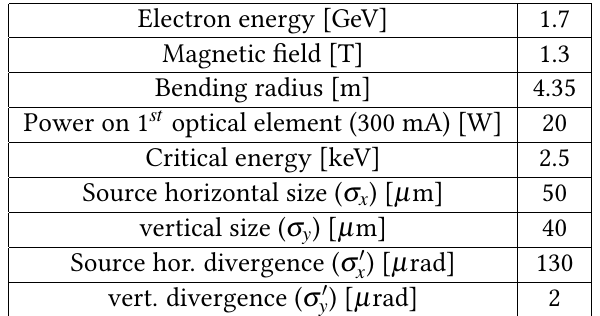
Table 1: BESSY II source characteristics of the dipole section DIP